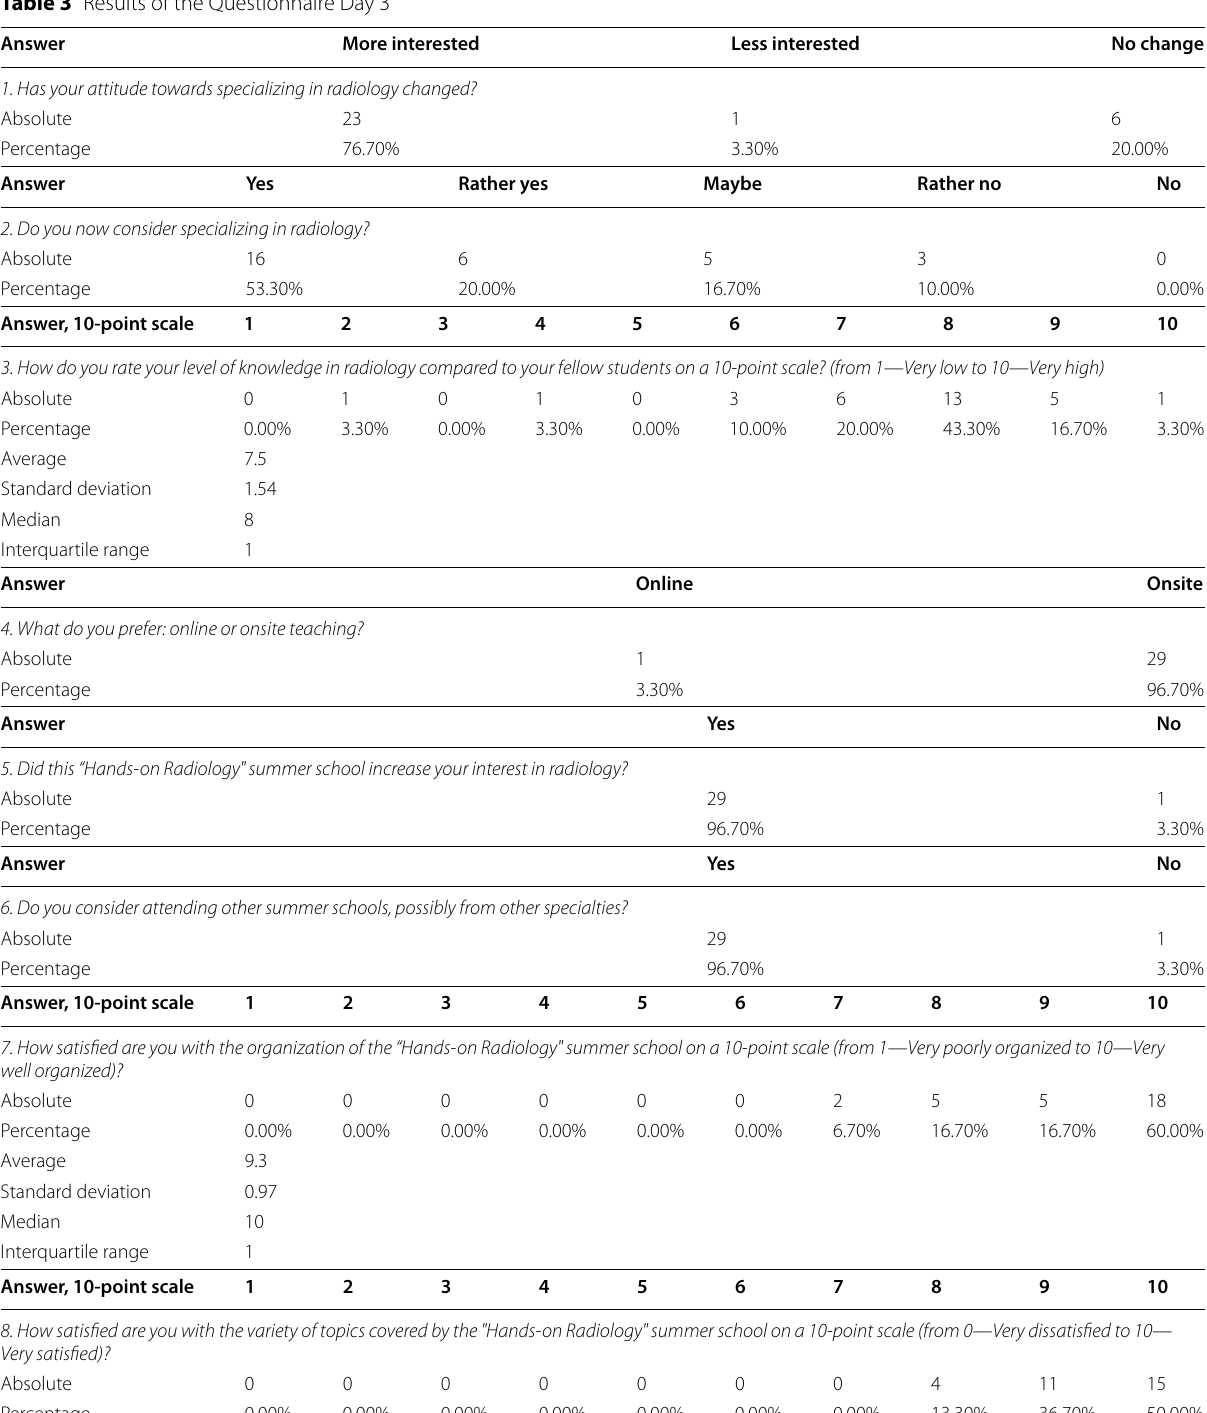
Table 3 Results of the Questionnaire Day